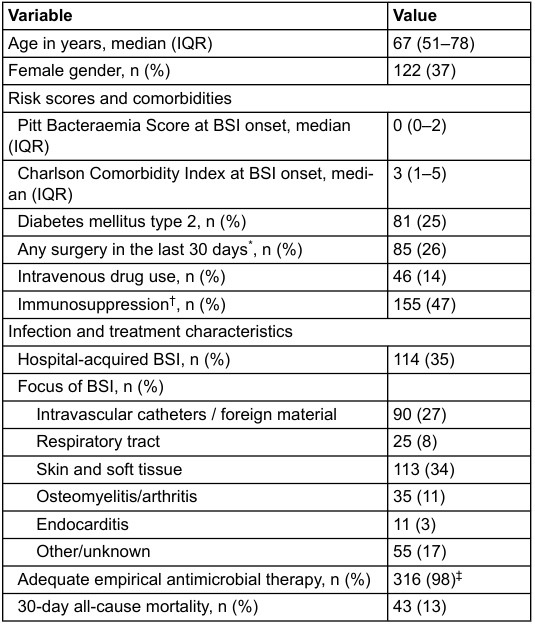
Table 1: Demographic and clinical characteristics of patients with a Staphylococcus aureus bloodstream infection (n = 329). Variable